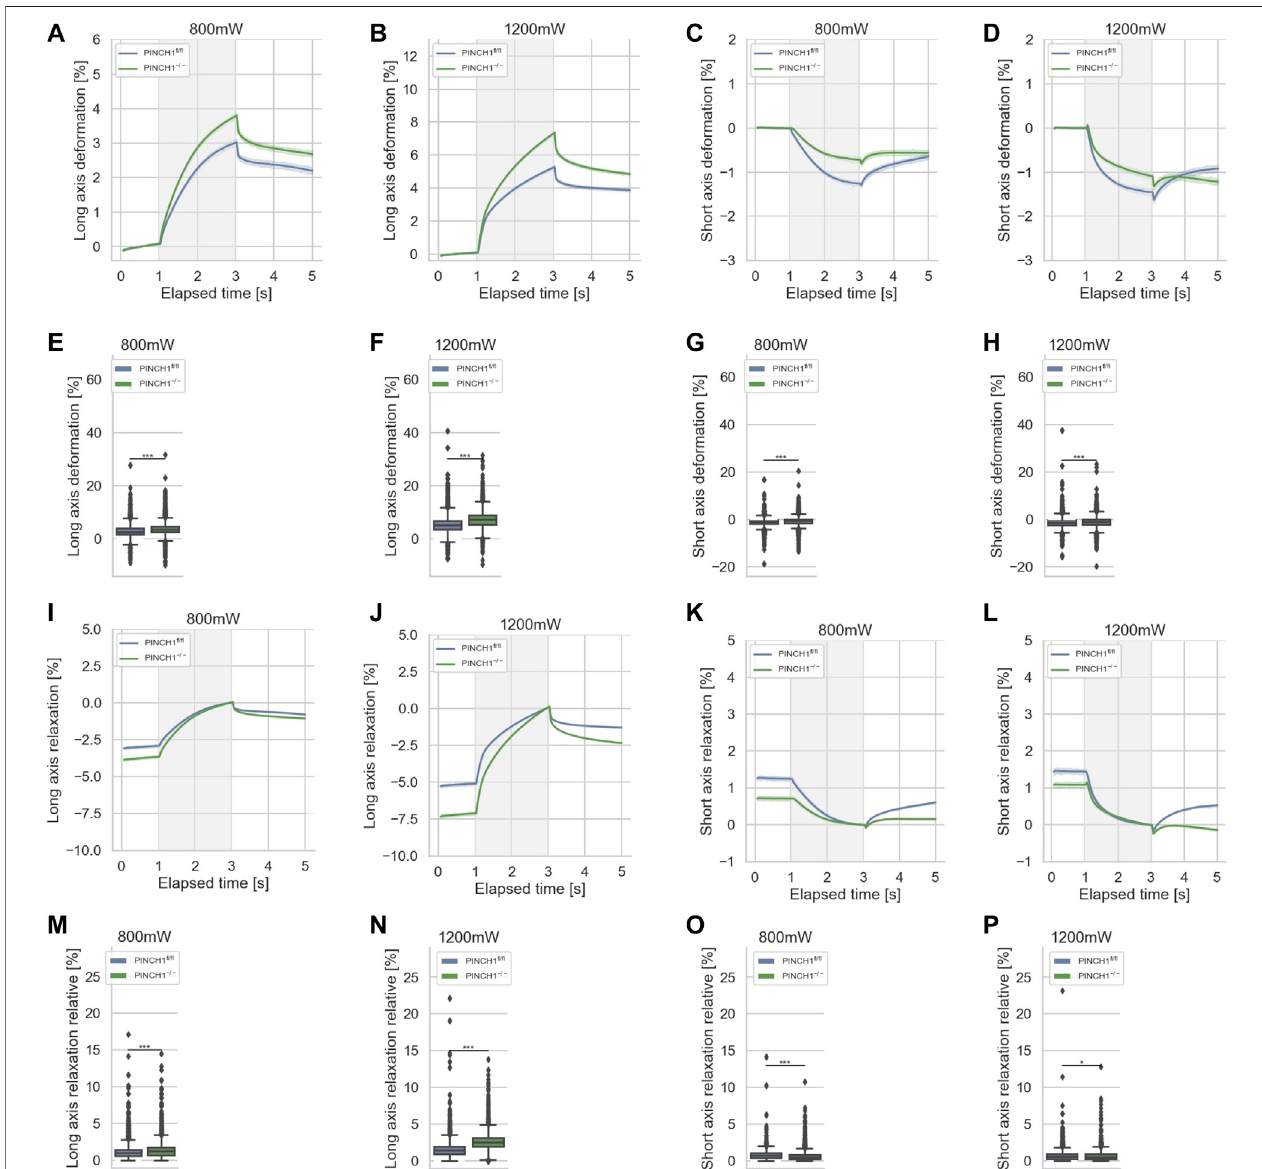
FIGURE 2 | Cellular deformability of PINCH1 − / − (green) and PINCH1 fl / fl cells (blue) was measured using an optical cell stretcher. During the fi rst second each cell is trapped,thenstretchedfor2swithamiddlelaserpowerof800 mWorahighlaserpowerof1,200mW.ThedeformabilitycurvesofPINCH1 − / − cellsandPINCH1 fl / fl cells at their long axis, which is parallel to the laser beams (A,B) , and short axis, which is perpendicular to the laser beams (C,D) . (E,F) Maximal deformability (at time point of 3 s)ofPINCH1 − / − cellsandPINCH1 fl / fl cellsatlaserpowersof800 mW(medianvalues, n =16,907cellsforPINCH1 − / − cellsand n =16,817cellsforPINCH1 fl / fl cells) to 1,200 mW (median values, n = 16,878 cells for PINCH1 − / − cells and n = 16,615 cells for PINCH1 fl / fl cells) at their long axis. (G,H) Maximal deformability of PINCH1 − / − and PINCH1 fl / fl cellsatlaserpowersof800 – 1,200 mWat theirshort axis.Afterthestretchingprocess, theviscoelasticrelaxation isobservedfor2 s.Relaxationbehavior curvesofthelongaxisforPINCH1 − / − cellsandPINCH1 fl / fl cellsatlaserpowersof800 mW (I) and1,200 mW (J) . (K,L) ShortaxisrelaxationcurvesofPINCH1 − / − cellsand PINCH1 fl / fl cellsatthetwolaserpowers. (M,N) Maximalrelaxation(attimepoint3 s,wherethedeformationismaximal)ofPINCH1 − / − cellsandPINCH1 fl / fl cellsatthetwo laser powers at their long axis. (O,P) Maximal relaxation of PINCH1 − / − and PINCH1 fl / fl cells at the two laser powers at their short axis. (A – D, I – L) data are presented as median values with a 95.0% con fi dence interval (E – H, M – P) data are presented as box and whiskers plots (Q2 represent median values). (A – P) The experiments have been conducted as 4 to 6 independent repetitions. (*** p < 0.001, * p < 0.05; Kruskal-Wallis test).